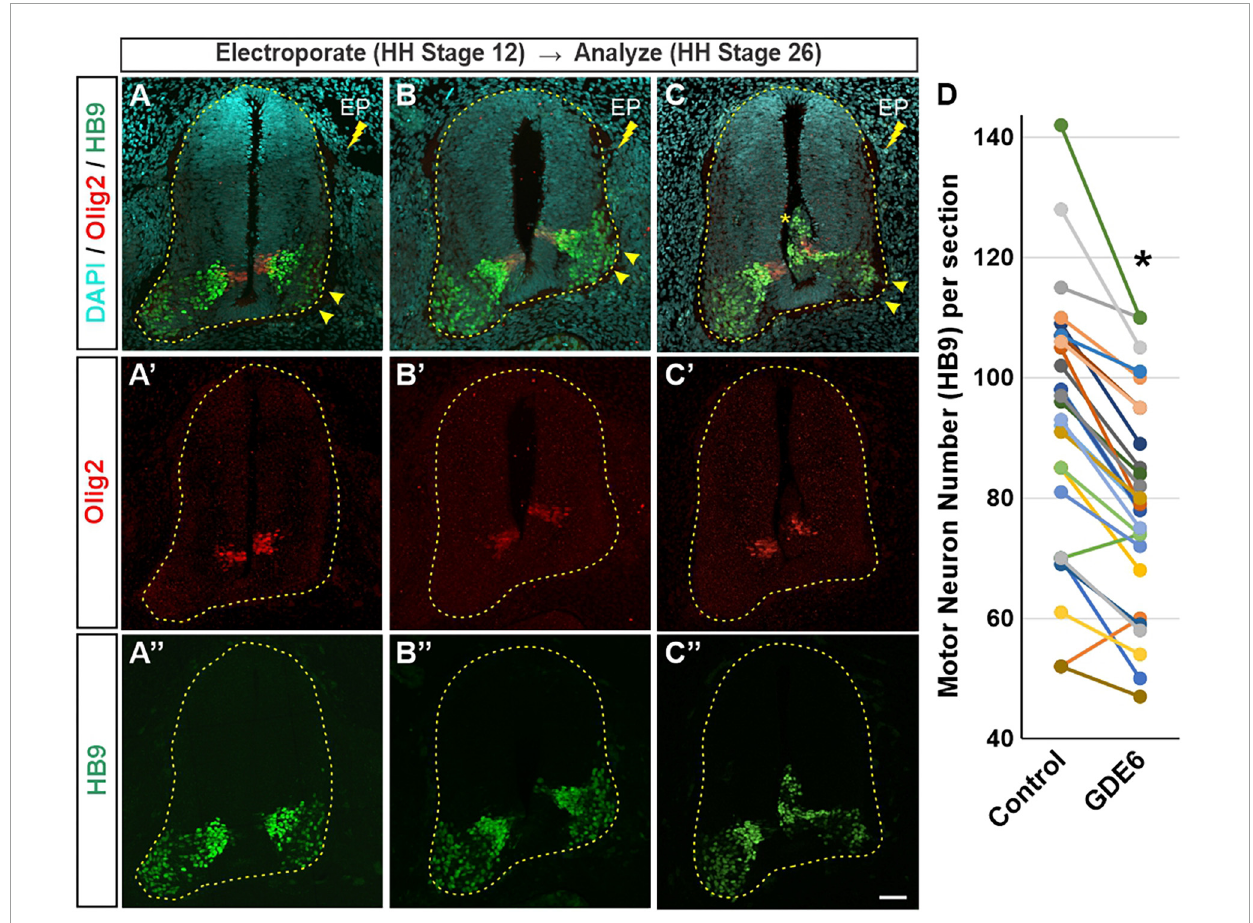
FIGURE4 GDE6 overexpression disrupts neurogenesis. (A–C”) Transverse sections of stage 26 neural tube electroporated at stage 19 with Flag-tagged GDE6. Overexpression of GDE6 impairs the production motor neurons. The electroporated half of the neural tube has reduced numbers of HB9 + motor neurons and underdeveloped ventral horns (arrowheads). Asterisk indicates ectopic growth into the ventricular lumen. Dashed line outlines the neural tube. (A–C) Are taken from different embryos. (D) Quantification of HB9 + motor neuron numbers in the ventral horn comparing control versus GDE6 halves. Paired two-tailed t -test, * p < 0.001, n = 26. Scale bar (A–C”) = 40 µ